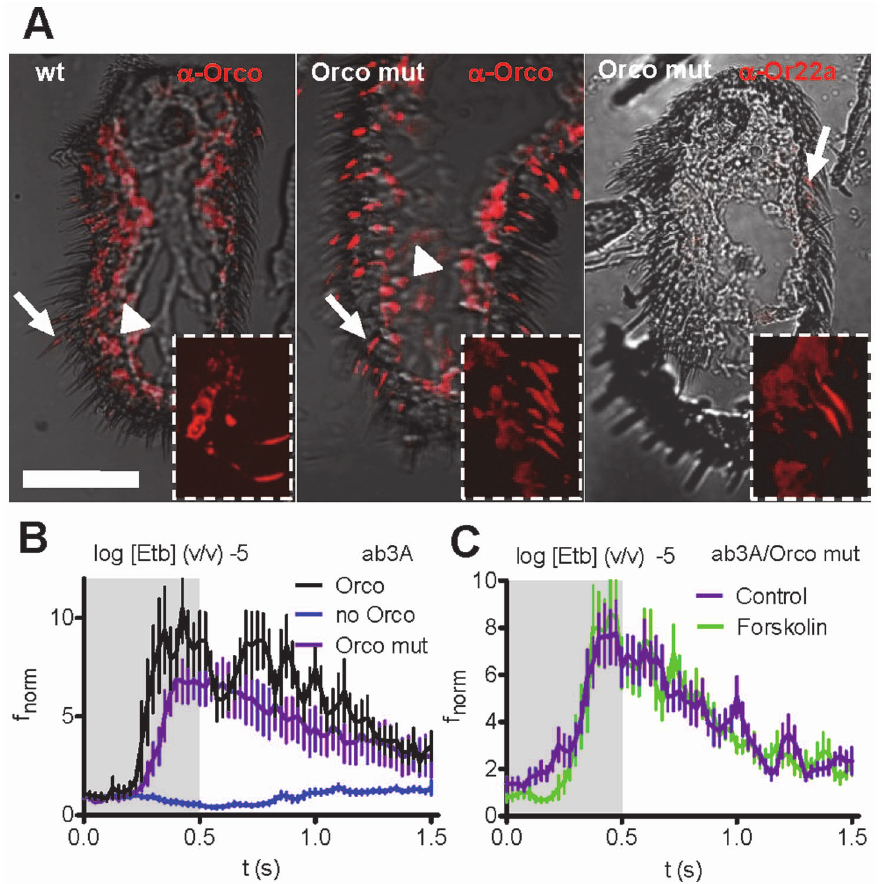
Figure 4. Regulation of OR response by cAMP signaling is intrinsic. A , Orco (left), Orco mut (middle) and Or22a (right) proteins visualized in adult antennal sections with specific antibodies (red). The proteins show expression in cell bodies (arrowhead) and dendrites (arrow). Or22a- expressing cells are housed in few sensilla opposite to arista (a). Scale bar 50 mm. B , Normalized ab3A neuron spike frequency (f norm ) upon Etb stimulation wild type flies (Orco, n =12), for Orco null mutants (no Orco, n =15), and mutants rescued with Orco mut (‘‘Orco mut flies’’; n =14; P =0.016 vs. Control, Mann-Whitney U test). C , f norm as in B upon Etb stimulation in Orco mut flies ( n =17) before (Control) and after forskolin